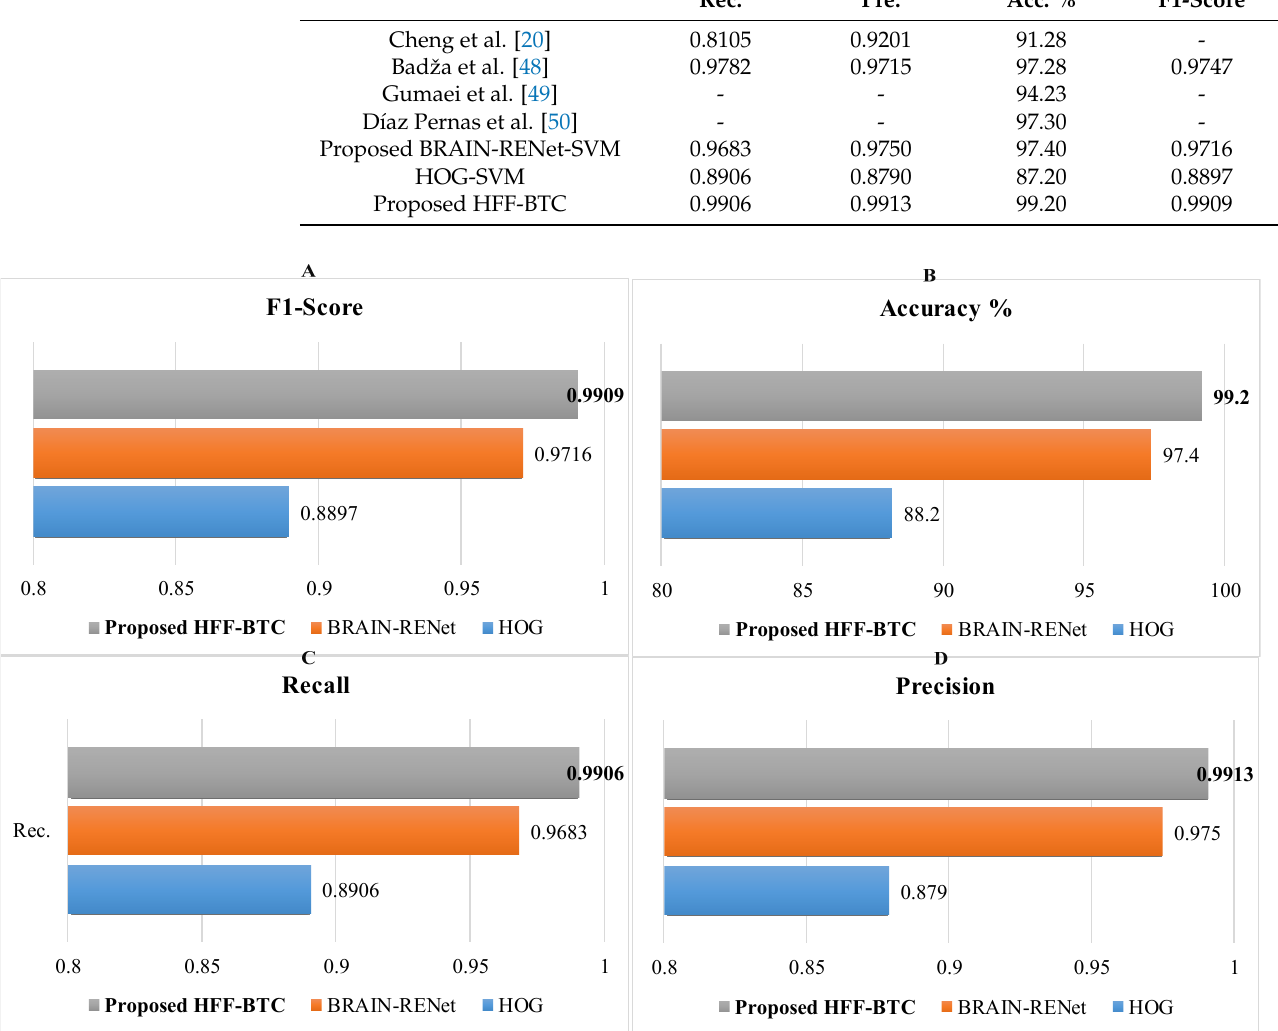
Table 8. Performance evaluation of proposed HFF-BTC with state-of-the-art models. Method